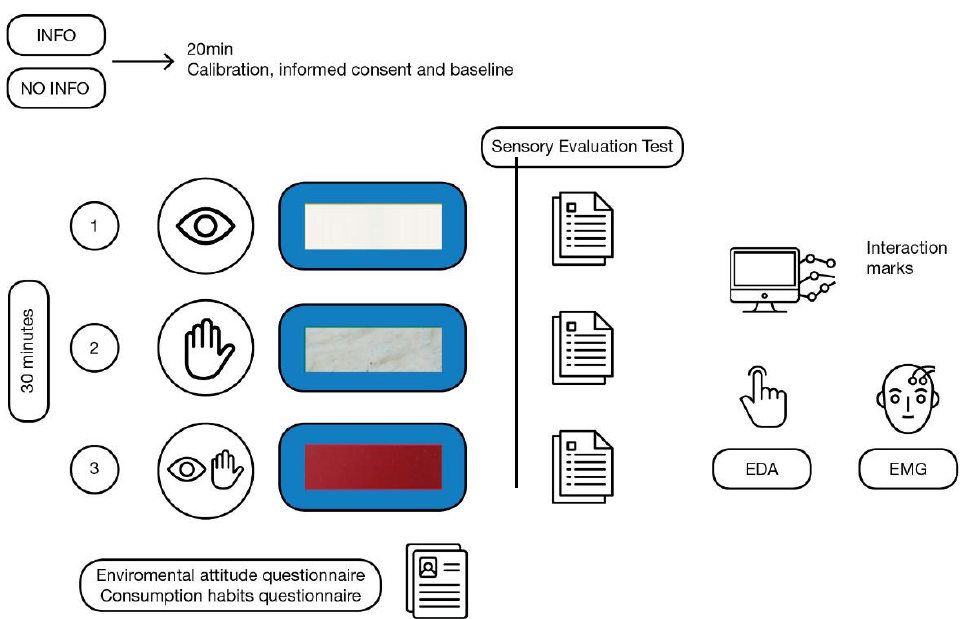
Figure 2. Procedure with EDA—electrodermal activity, EMG—electromyography, and sensory evaluation test.